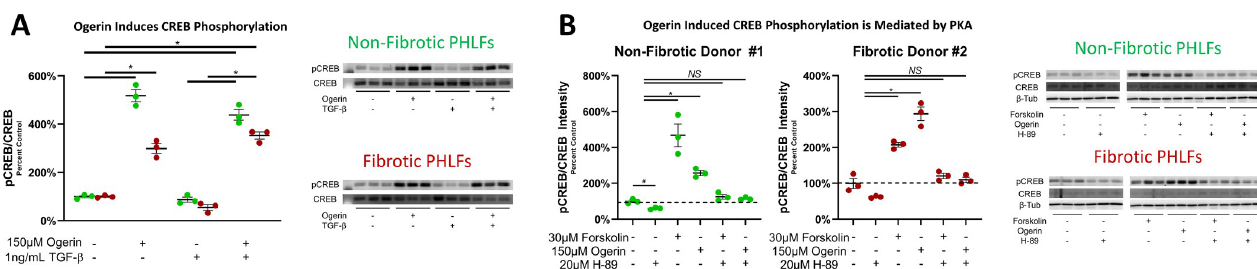
Fig 6. Ogerin induces G α s signaling as evident by PKA dependent CREB phosphorylation. A: Primary human lung fibroblasts derived from non-fibrotic or IPF patients were co-treated with 1ng/mL TGF- β and/or 150 μ M Ogerin for 40 Minutes. Whole cell lysates analyzed for phosphorylated CREB expression via Western Blot. Phosphorylated CREB intensity was standardized to total CREB expressed as a percent of control. n = 3 per donor per treatment group, dots representative of technical replicates with SEM. B: Primary human lung fibroblasts derived from non-fibrotic or IPF patients pre-treated with 20 μ M of the PKA Inhibitor H-89 for 30 minutes followed by +/- 30 μ M Forskolin or +/- 150 μ M Ogerin for 40 Minutes. CREB phosphorylation was analyzed as described for 6A. � = p < 0.05, NS = Not Significant by One -Way ANOVA with Tukey’s Post-Hoc Test for Multiple